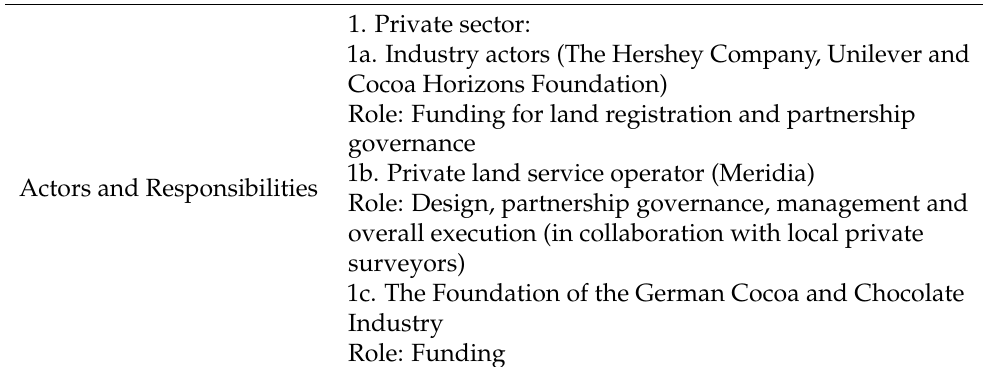
Table 1. CLAP as a FFPLA